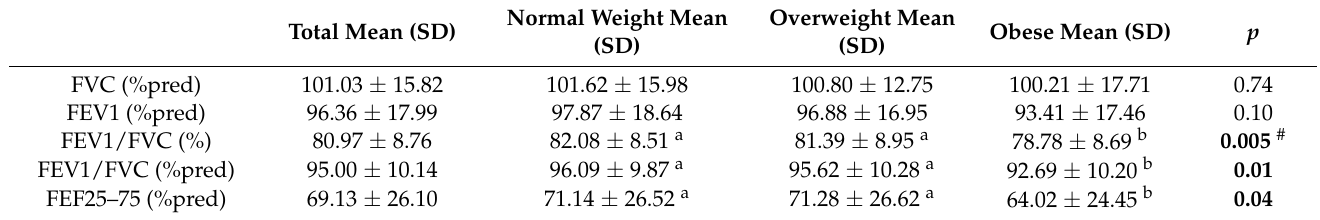
Table 2. Comparison of spirometric variables among the study